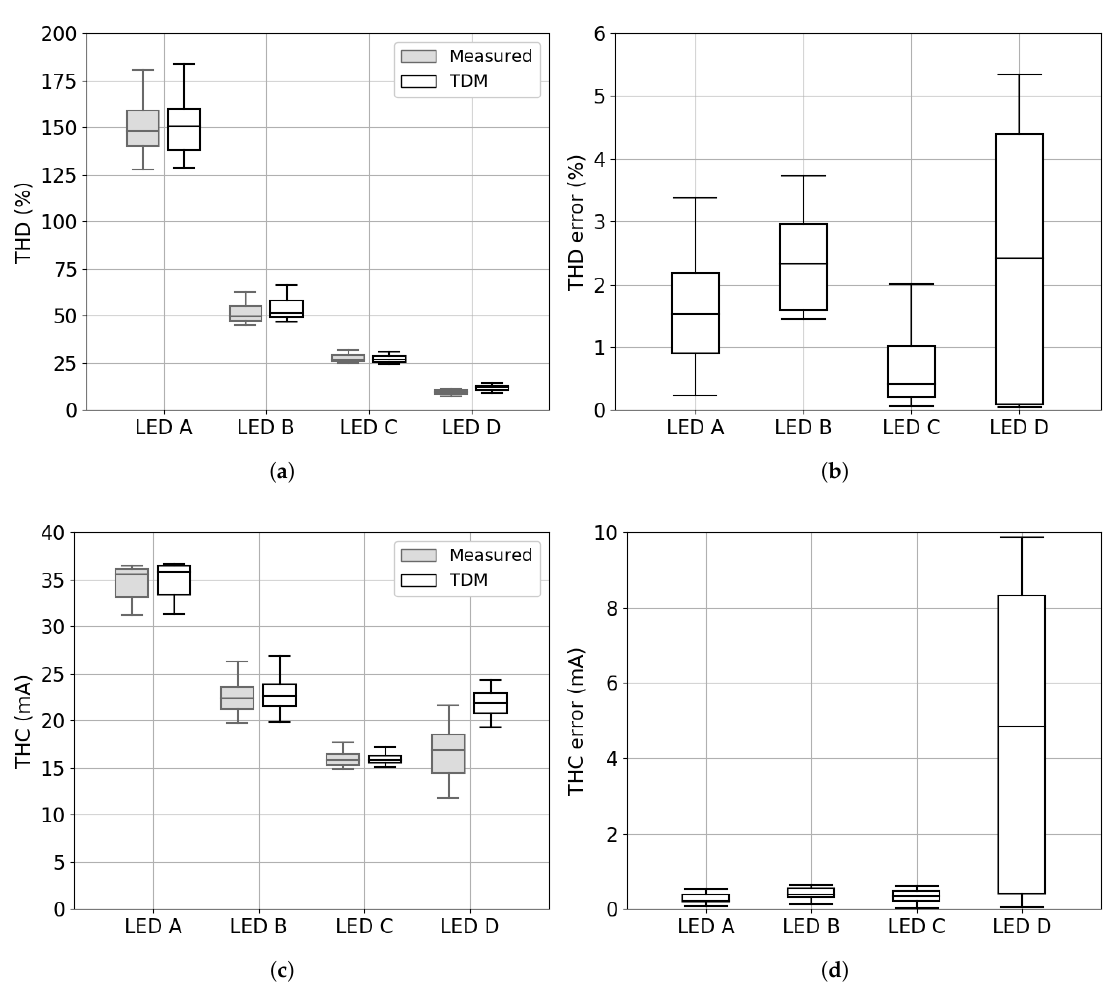
Figure 8. Comparison of the time-domain model (TDM) and the measured data for all test points: ( a ) THD; ( b ) THD error (absolute values); ( c ) THC; and ( d ) THC error (absolute